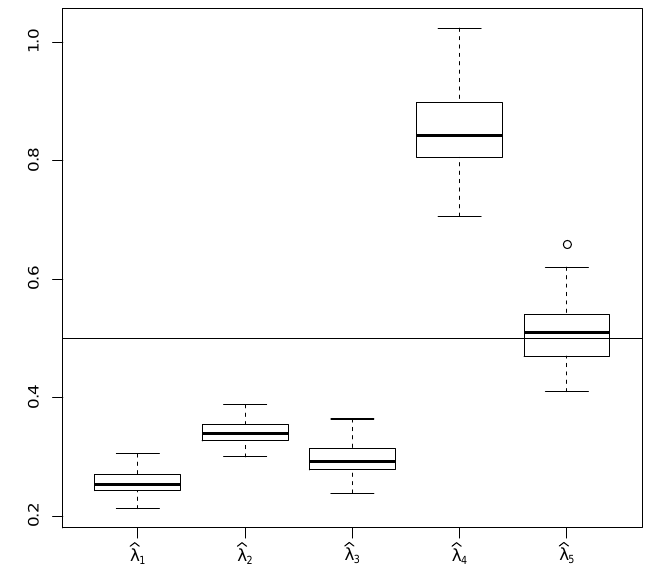
Figure 5. Comparison of (cid:98) λ 1 , (cid:98) λ 2 , (cid:98) λ 3 , (cid:98) λ 4 and (cid:98) λ 5 for 100 trajectories, where H = 0.75, x 0 = 100, T = 1000, h = 1, σ = 2; the horizontal line shows the true value of the estimated parameter λ = 0.5.